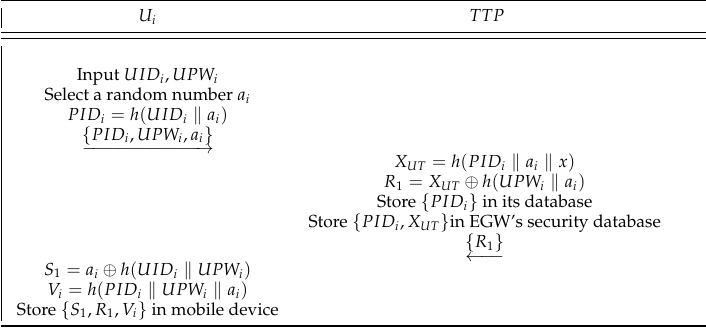
Figure 3. U i registration